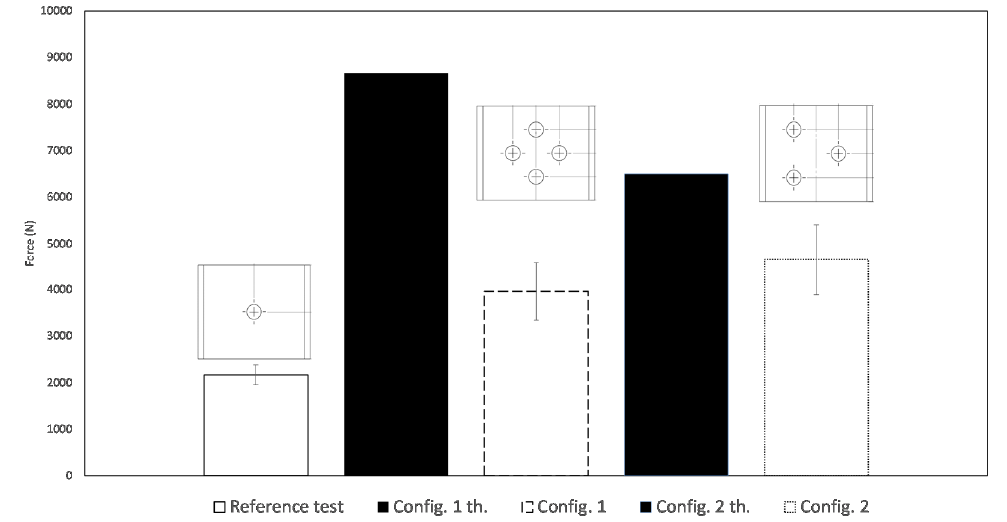
Figure 5. Expected and experimental maximum values for each